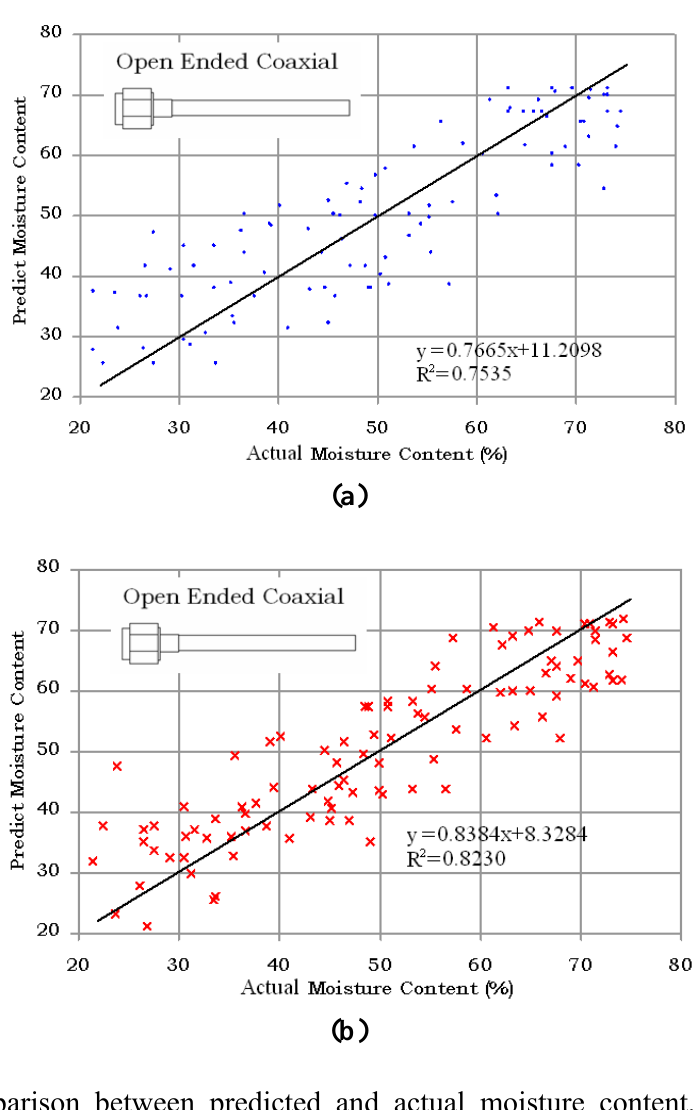
Figure 7. Comparison between predicted and actual moisture content. (a) Magnitude; (b) Phase methods using coaxial sensor.